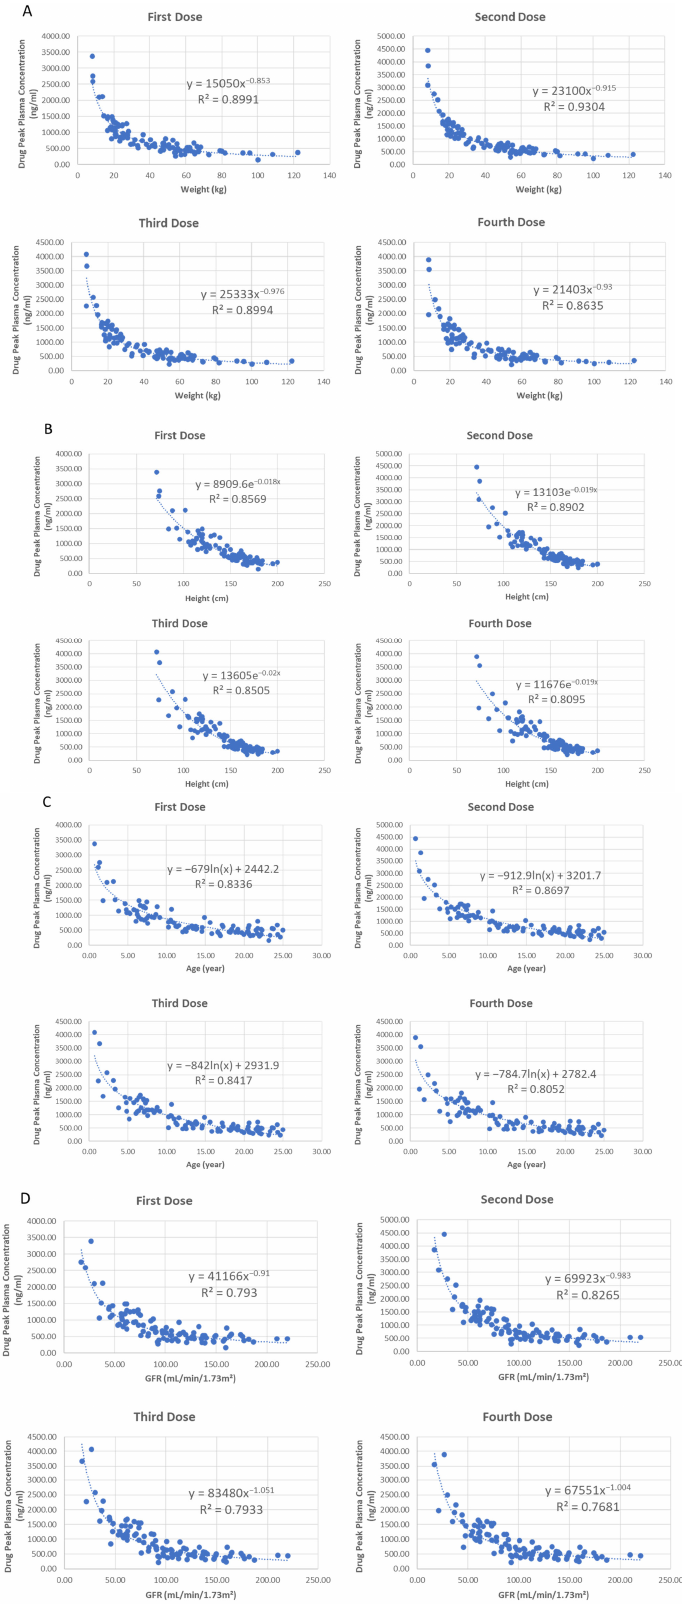
Figure 11. The regression models for pediatric population between physical parameters ( x ‐ axis: weight, height, age, and GFR) and drug peak concentrations after four doses ( y ‐ axis). ( A ): Power model. ( B ): Exponential model. ( C ): Logarithmic model ( D ): Power model.